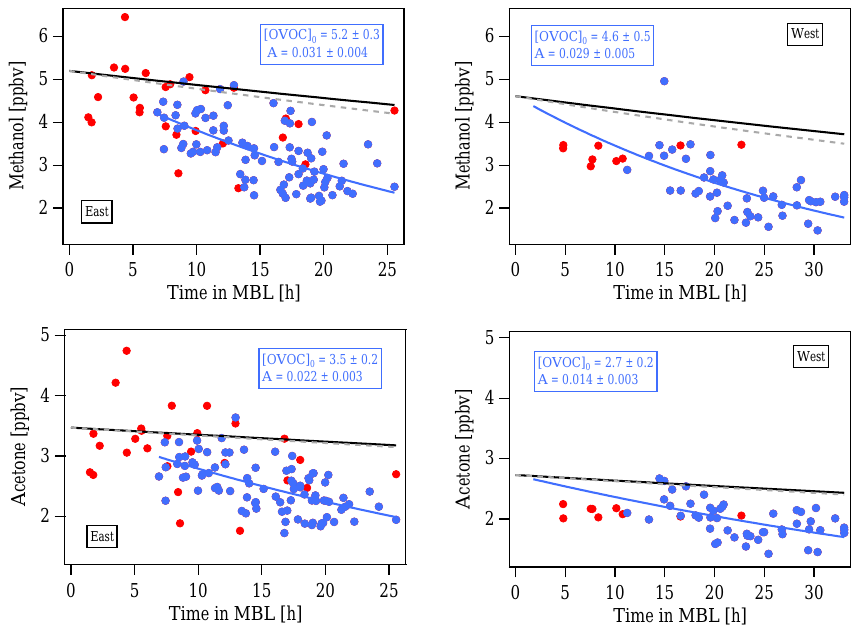
Figure 9. Data of acetone and methanol separated by eastern and western air masses, plotted against the time in the MBL. The data measured within the PBL (marked in blue) were fitted using an exponential fit algorithm (blue line). The black lines refer to calculated losses using Eq. (4) and the dry-deposition velocities from the EMAC model. The gray dashed line was calculated using a 28.5% higher OH concentration. The red marks represent data points measured when the site was within the residual layer/free troposphere. These were excluded for the calculation of the exponential fit. [OVOC] 0 and A refer to equation 3 and are given in units of ppbv andh − 1 ,